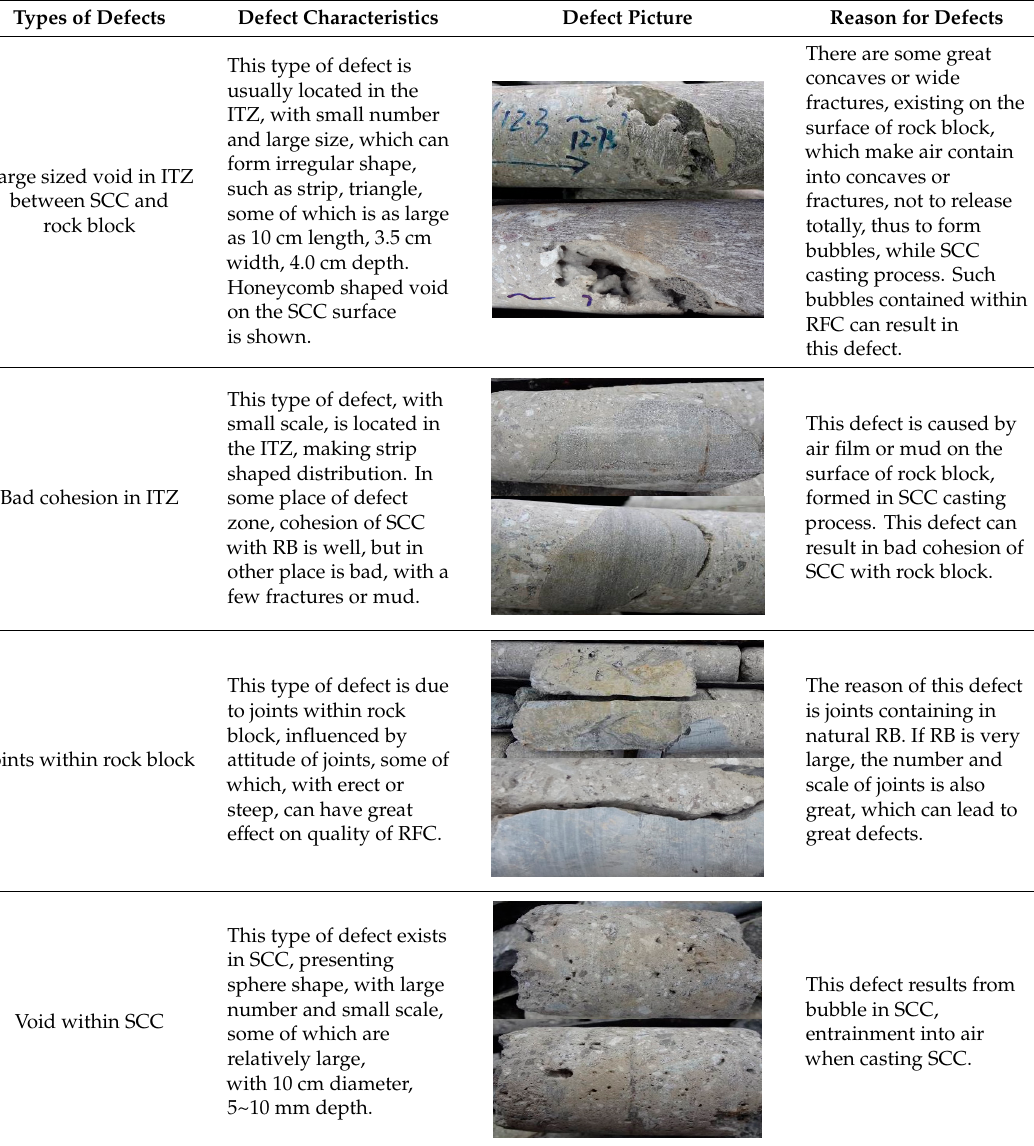
Table 1. Defect types in RFC.